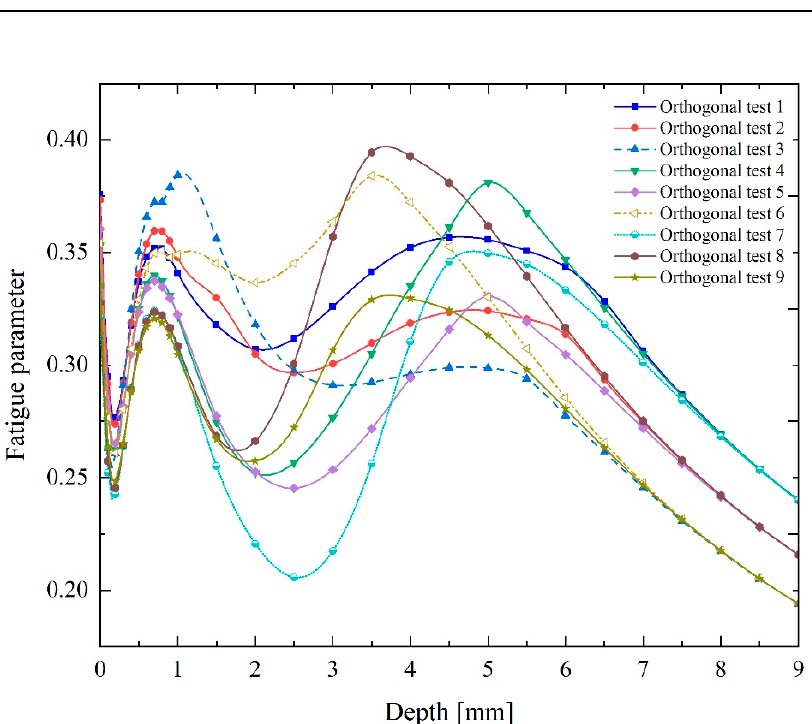
Figure 21. Influence of hardness gradient on fatigue parameters. Table 3. Impact factor and level.